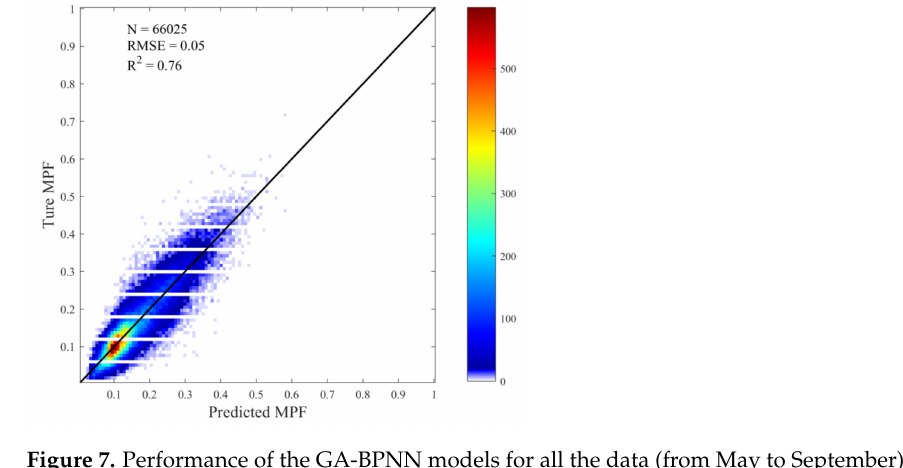
Figure 7. Performance of the GA-BPNN models for all the data (from May to September). The color gradient represents the density of the scatter in each grid.